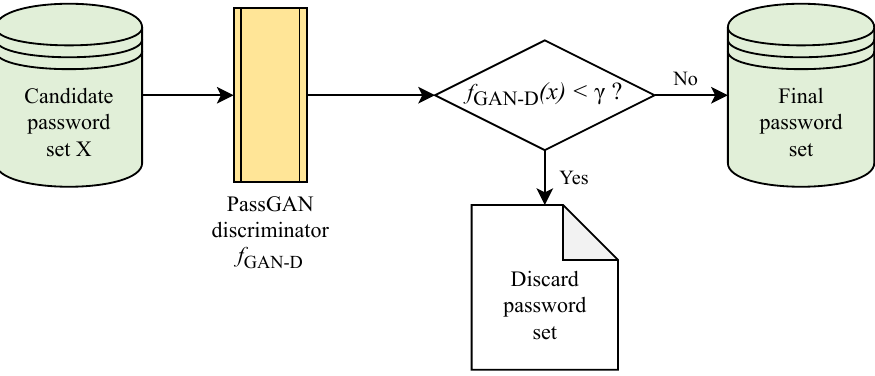
Figure 2. The password choosing procedure of